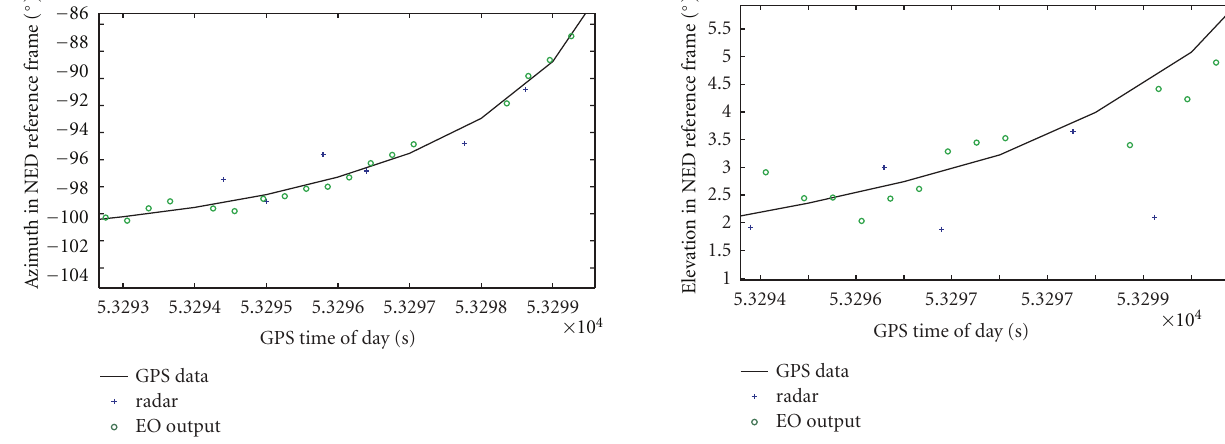
Figure 12: Comparison of intruder azimuth in NED reference frame among radar, EO, and the postprocessing of GPS data output that is used as reference.